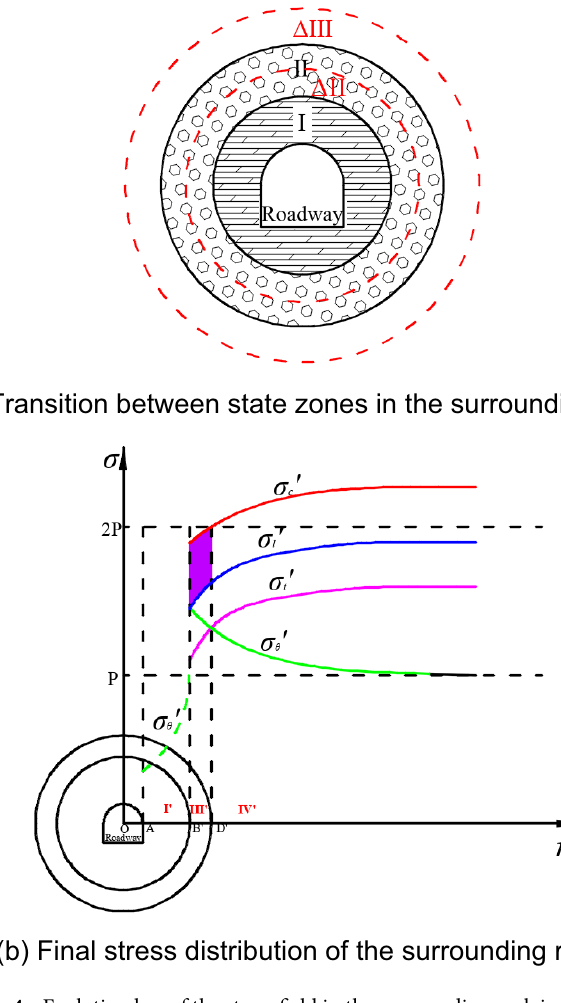
Figure 4. Evolution law of the stress field in the surrounding rock in the creep perturbation state.